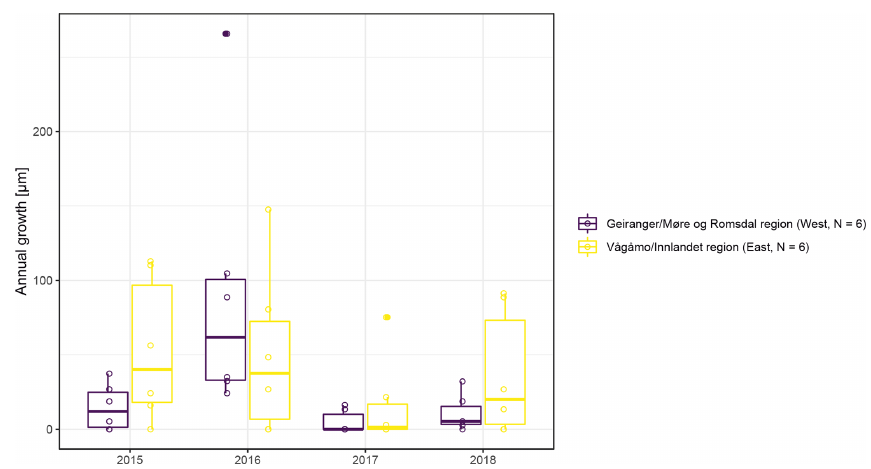
Figure A6. Boxplots of observed annual growth within each of the two study regions (Vågåmo, Innlandet, region (east, N = 6) and Geiranger, Møre og Romsdal, region (west, N = 6)).